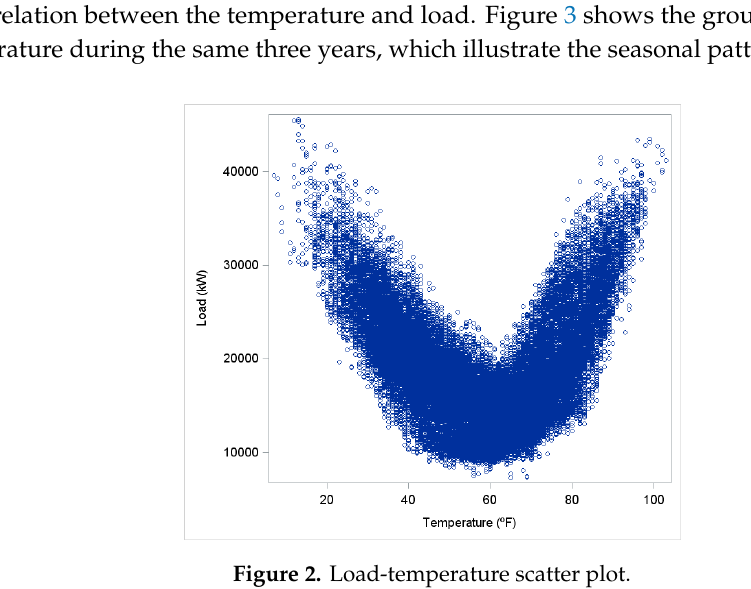
Figure 2. Load-temperature scatter plot.